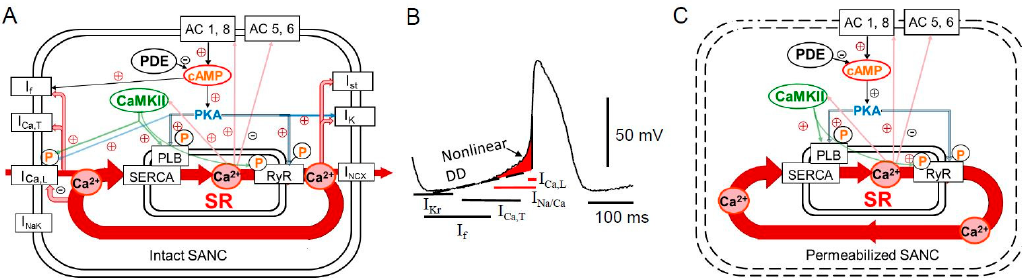
Figure 1. A simplified schematic illustration of regulation of the basal cardiac pacemaker function by Ca 2+ , and PKA- and CaMKII-dependent phosphorylation in intact and permeabilized rabbit SANC. ( A ) The coupled-clock pacemaker system. Intracellular Ca 2+ cycling (in red) operates in tight cooperation with the ensemble of membrane ion channels. Note that L-type Ca 2+ channel and I NCX current are both Ca 2+ cycling proteins and surface membrane currents. Constitutive activation of the basal AC activity results in an elevated level of cAMP and cAMP/PKA-dependent phosphorylation. The basal Ca 2+ /cAMP-PKA “feed-forward” regulation is kept in check by a high basal PDE activity. Many ion currents including (I f , I st , I Ca,L , I Ca,T , I K , etc.) are regulated by Ca 2+ . Both PKA- and CaMKII-dependent phosphorylation modulates the function of Ca 2+ cycling proteins (PLB, RyR, L-type Ca 2+ channel, and I NCX current). ( B ) Schematic illustration of spontaneous SANC action potential and major currents involved in generation of the diastolic depolarization. See text for additional details. LCR-induced increase in [Ca 2+ ] beneath sarcolemma activates an inward I NCX current creating exponential increase in the diastolic depolarization rate. ( C ) Schematic illustration of permeabilized SANC in the absence of functional ionic currents. Ca 2+ cycling by the SR in permeabilized SANC becomes “free running” and is controlled mostly by the concentration of free cytosolic [Ca 2+ ] f and the kinetics of Ca 2+ pumping into SR and release from RyR. See text for additional details.